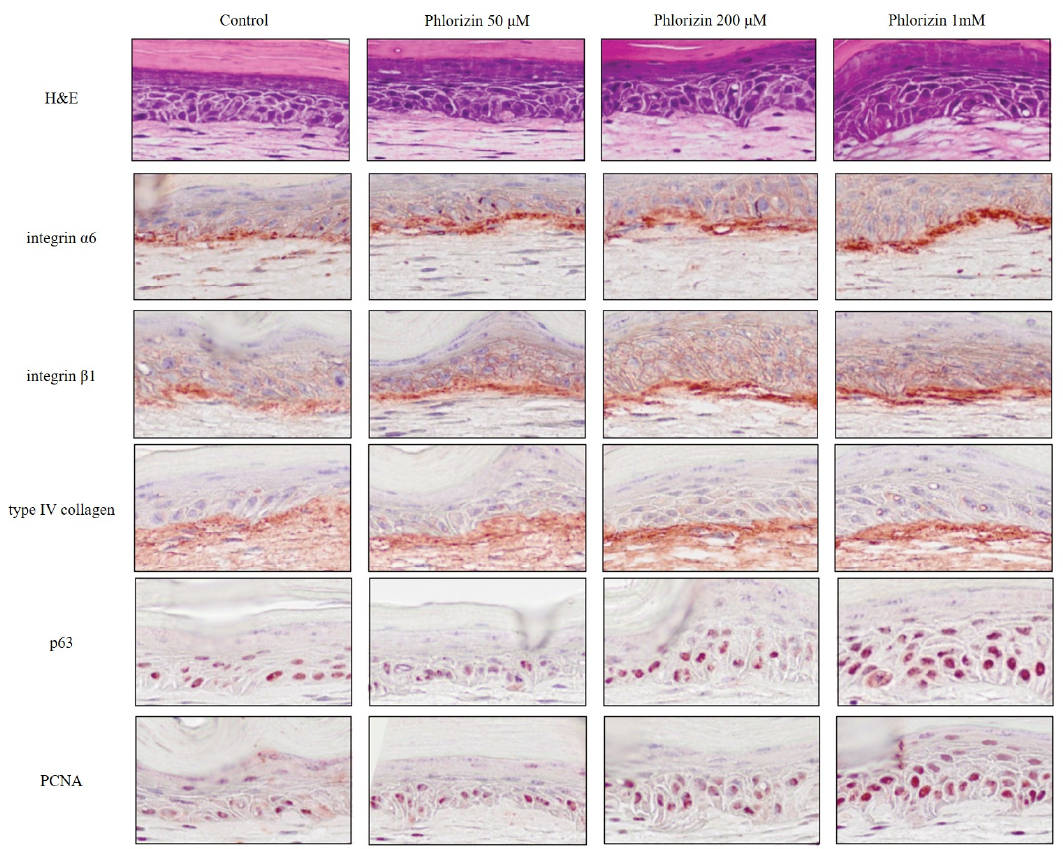
Figure 2. Histological and immunohistochemical findings for phlorizin-treated skin equivalents. Skin equivalents were constructed and incubated in the presence of phlorizin (0, 50, 200 μM or 1 mM). Sections of skin equivalents were stained with hematoxylin and eosin (H&E), and analyzed by immunohistochemical staining for integrin α6, integrin β1, type IV collagen, p63, and PCNA (magnification × 200). (modified from the work by Choi et al. [9] )